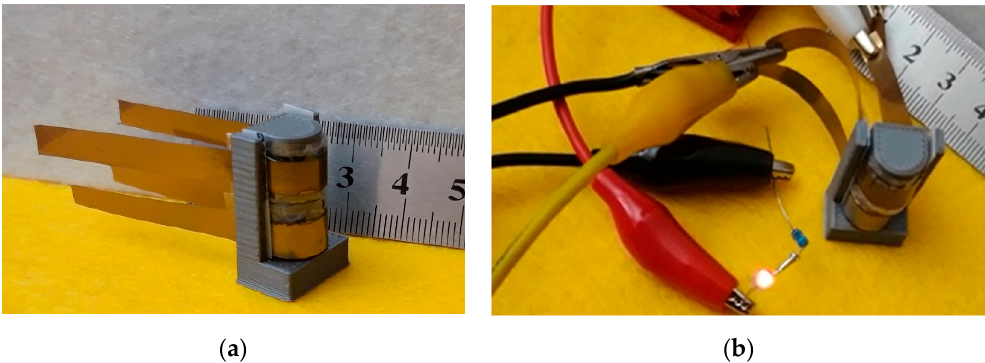
Figure 16. ( a ) Photograph of the sample holder used for bending tests. Two devices, each with an active area of about 1 cm 2 , were inserted into the stage, curvature radius of which was 5 mm; ( b ) picture taken 5 seconds after disconnecting the voltage supply used to charge the two capacitors (in series) inserted into the bending stage to 4 V: the LED remained lit by the charge stored in the devices for several seconds.